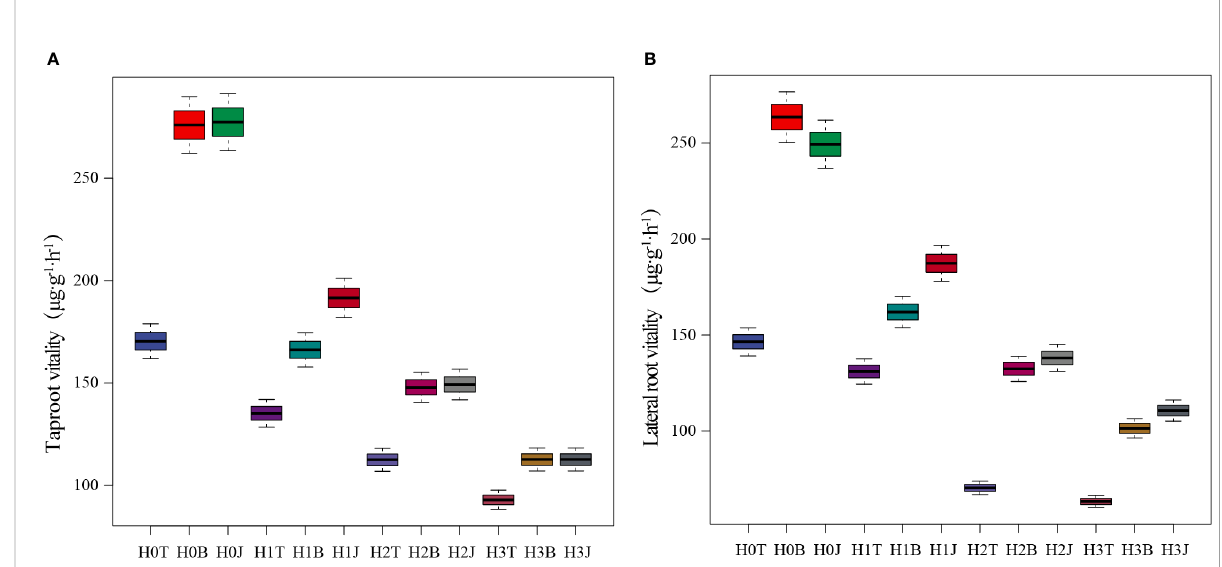
FIGURE 1 Effect of biochar and biofertilizer applications on the vitality of cotton taproot (A) and lateral root (B) . Notes: T, no modi fi ers; B, 3% biochar was applied; J, 1.5 % biofertilizer was applied; H0, no Cd; H1, 1 mg·kg-1 of Cd was applied; H2, 2 mg·kg-1 of Cd was applied; H3, 4 mg·kg-1 of Cd was applied. The same